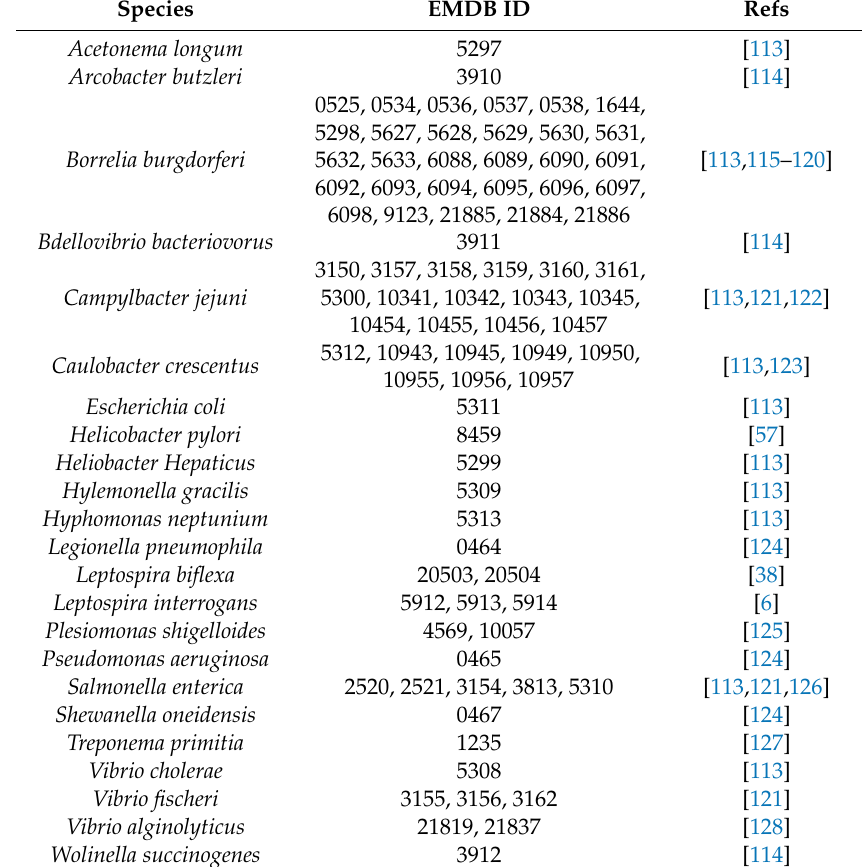
Table 3. In situ flagellar motors visualized by cryo-ET. A list containing the cryo-ET maps of flagellar motors deposited in the EMDB. Note that not all cryo-ET maps are